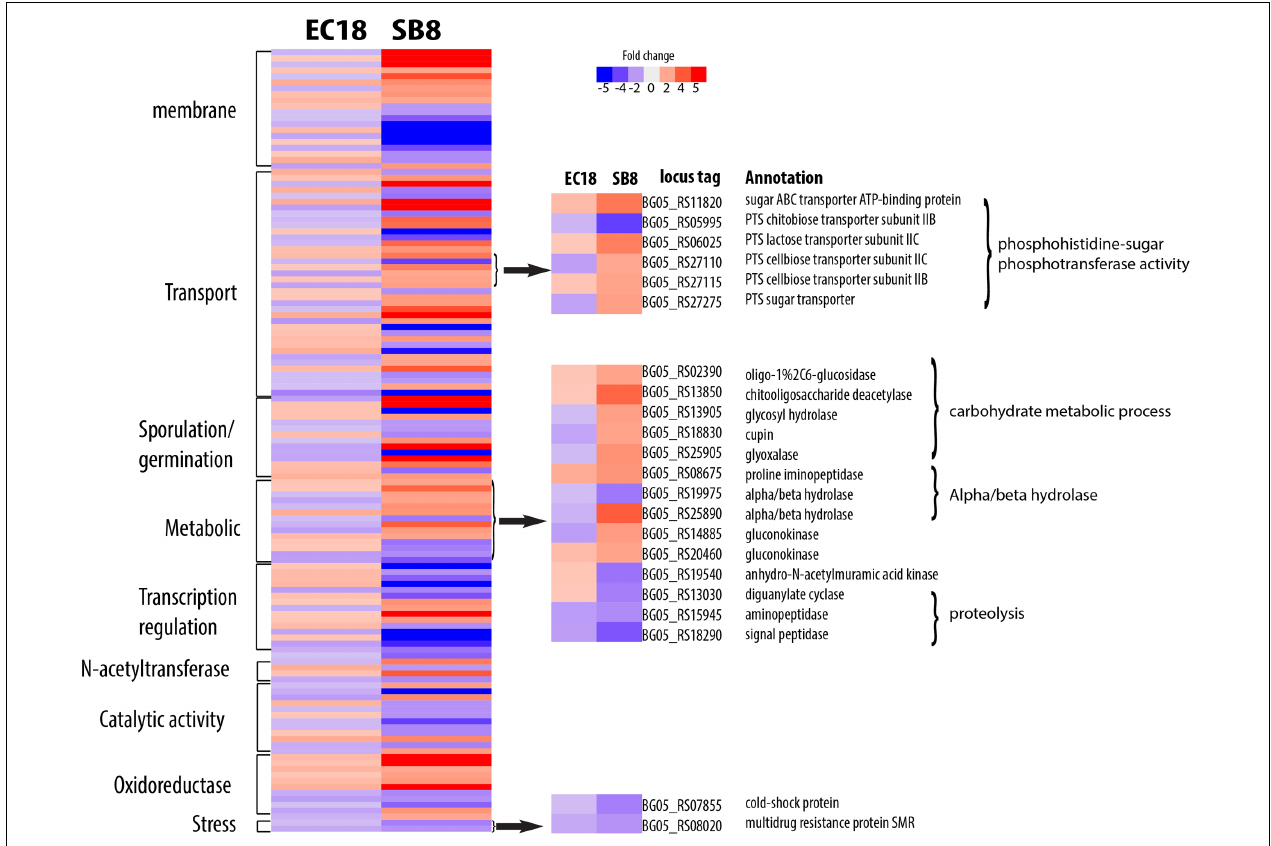
FIGURE 8 | Differentially expressed genes specifically present in the soil strain B. mycoides SB8 in response to root exudates. Red represents significant upregulation and blue indicates significant downregulation of gene